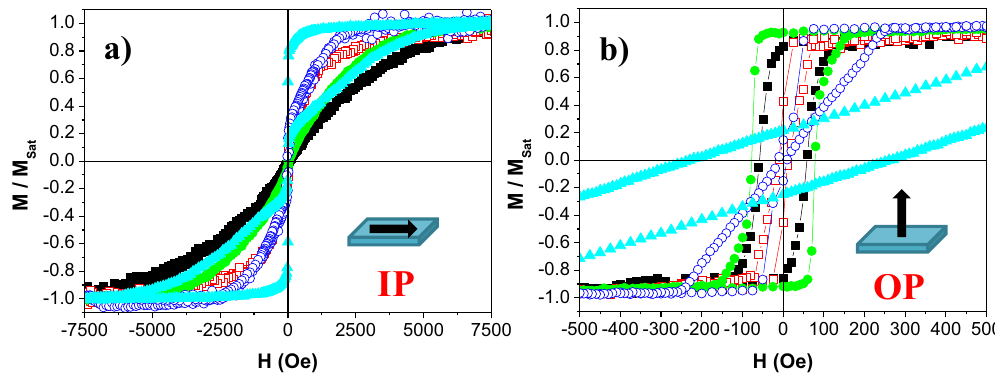
Figure 1. In-plane ( a ) and out-of-plane ( b ) hysteresis loops of [CoFeB ( t CoFeB )/Pd (10 with t CoFeB = 1 (Black filled square), 2 (red open square), 3 (green filled circle), 4 (dark blue open circle) and 5